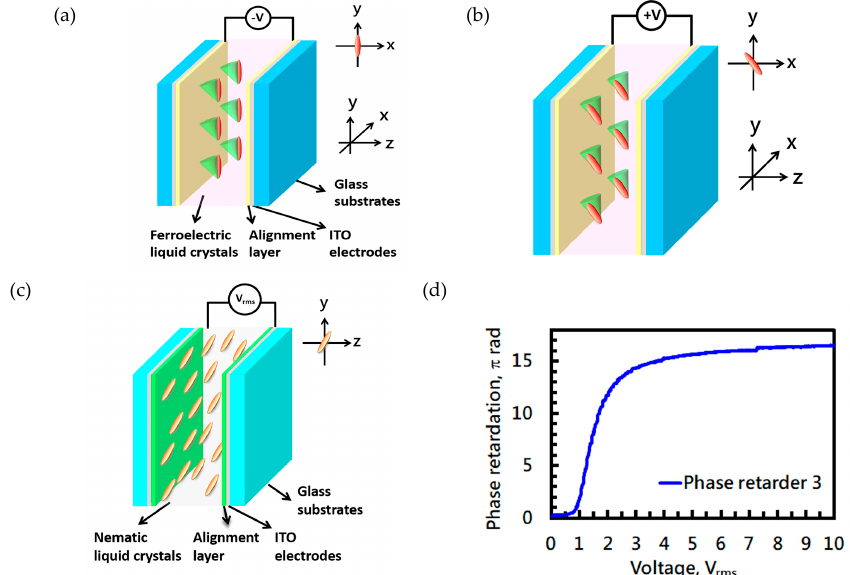
Figure 19. ( a ), ( b ) Geometry of FLC phase retarders 1 and 2. ( a ) The applied voltage is − 10 V and ( b ) + 10 V. ( c ) Geometry of nematic LC phase retarder 3 in the absence of an electric field. ( d ) Plot of phase retardation versus the applied voltage for phase retarder 3.